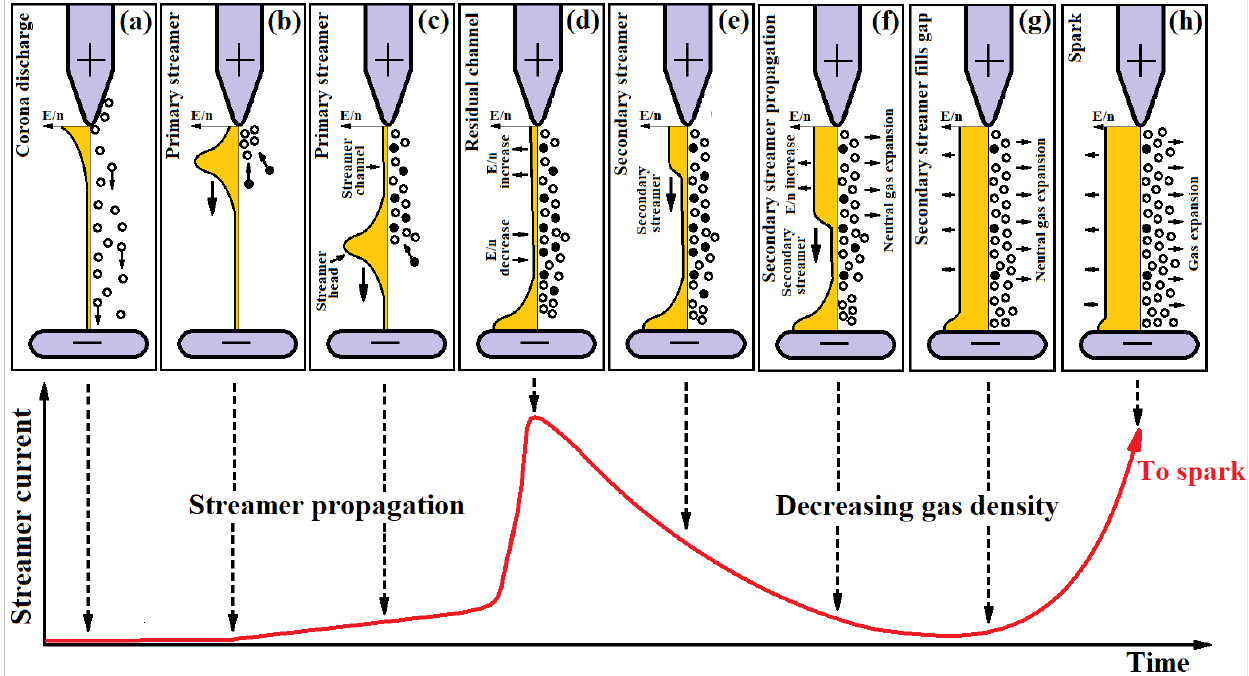
Figure 2. Steps of primary and secondary streamers progressive developments [26]. The black circles represent electrons, while the white circles symbolize positively charged